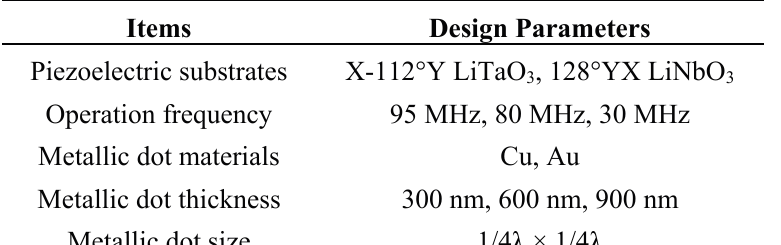
Table 2. Design parameters for the SAW sensor chips.